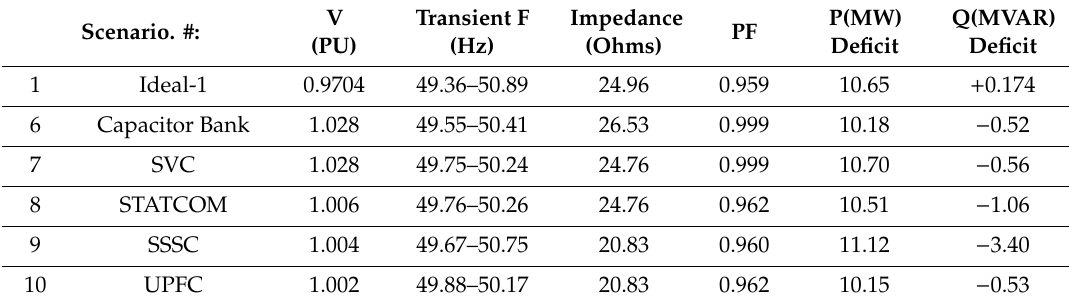
Table 3. Comparison of various